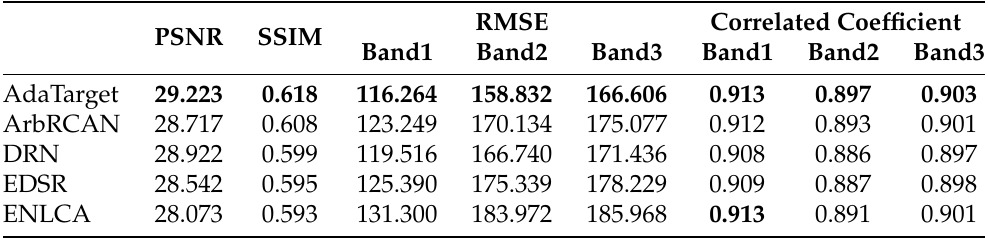
Table 3. Radiometric and structural evaluation on FY4ASRcolor with pre-trained parameters.